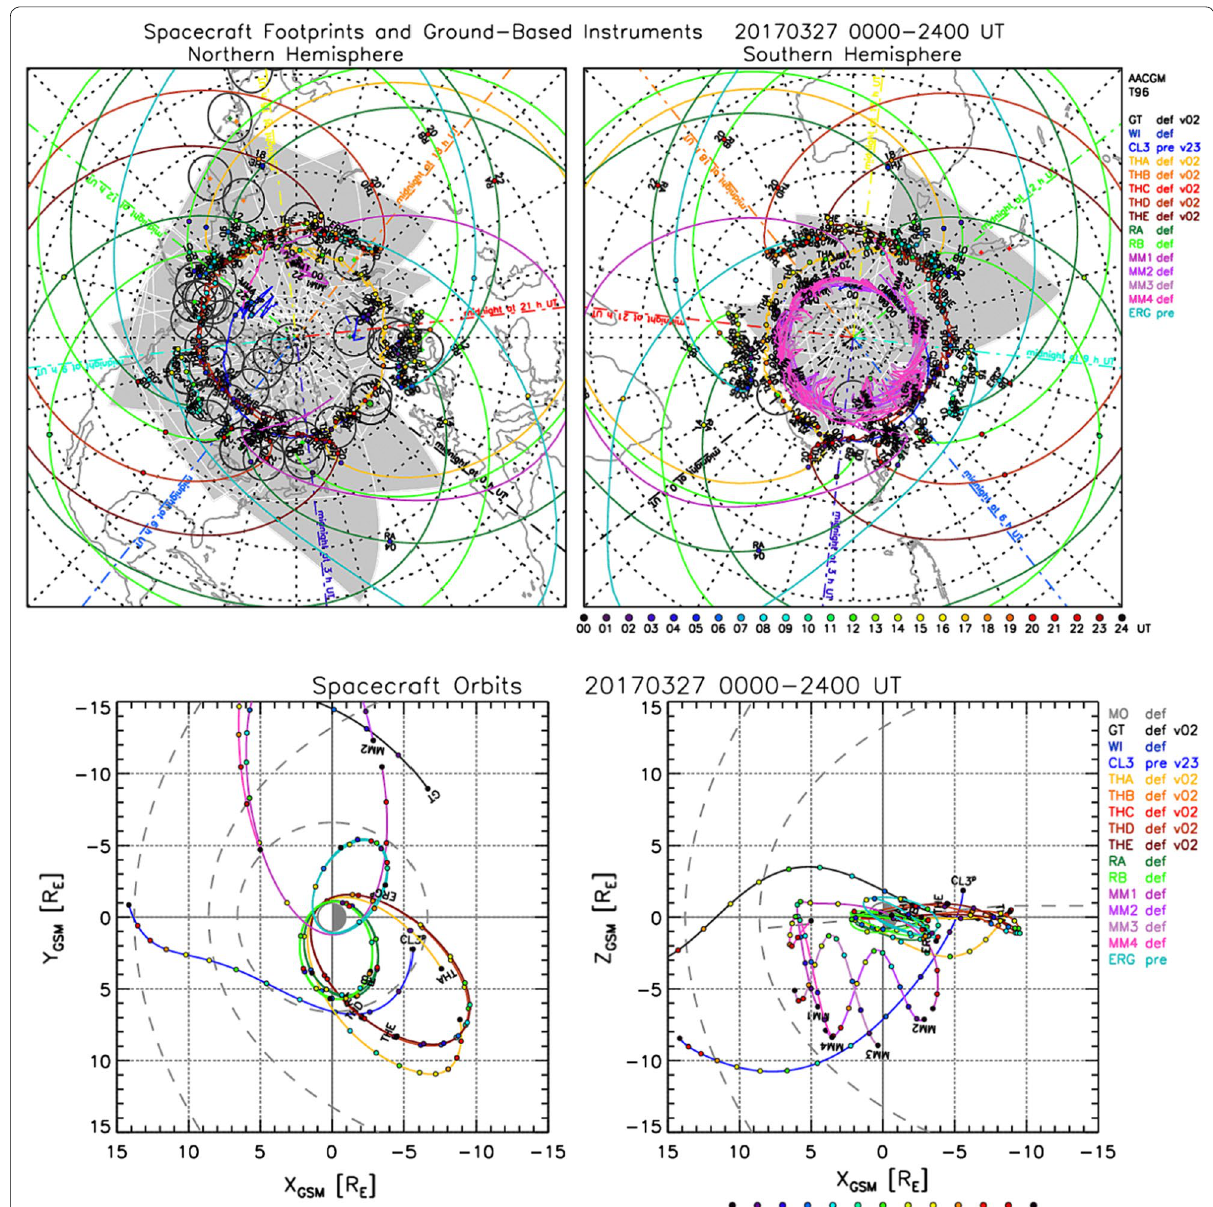
Fig. 14 An example of CEF. (top) Spacecraft footprints and FOVs of all‑sky imagers and radars on top of the global maps. (bottom) Projections of spacecraft trajectories in the